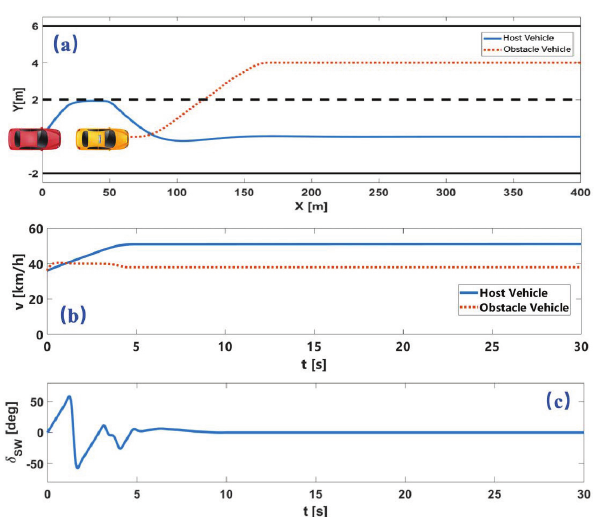
Figure 11. Simulation results of lane-changing obstacle avoidance. Here, ( a ) is vehicle trajectory. ( b ) is vehicle velocity. ( c ) is steering wheel